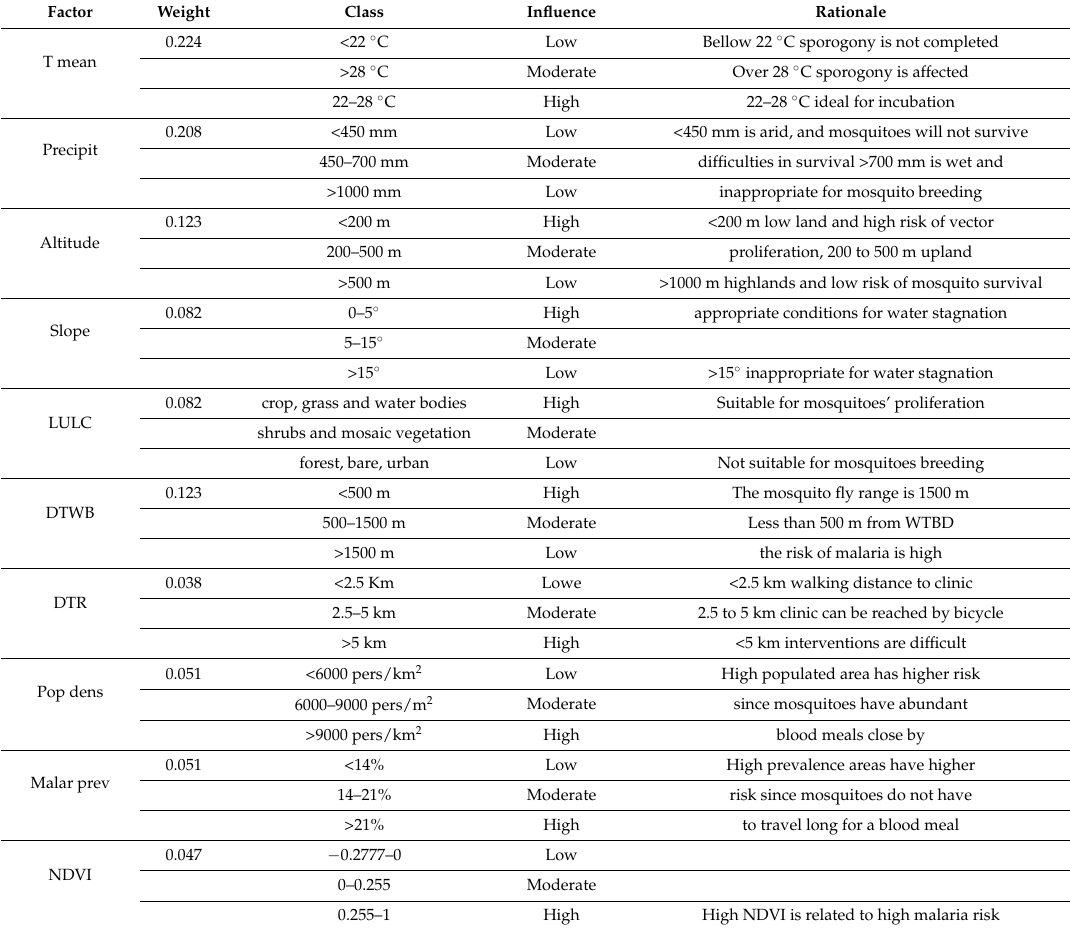
Table 1. Classification, weighing and rationale of the malaria risk